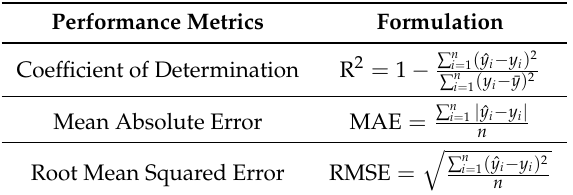
Table 1. The performance metrics used in the sensitivity analysis for the PN models’